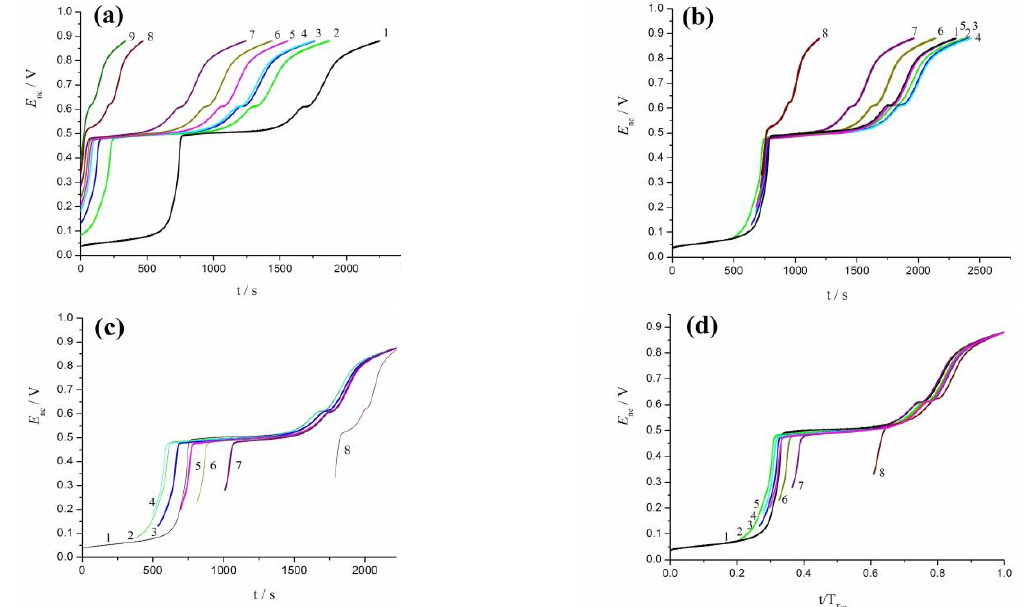
Figure 8. ( a ) Transients of non-current potential in water saturated with CO 2 after the delay of potentials E in Volts (the number of curve): black line: 0. 03 (1); green line: 0.08 (2); blue line: 0.130 (3); cyan line: 0.180 (4); magenta line: 0.200 (5); dark yellow line: 0.230 (6); purple line: 0.280 (7); wine line: 0.330 (8); and, olive line: 0.380 (9). ( b ) Corrected transients of non-current potential by the shift each of the curves (Figure 8a) on the t -axis at the corresponding times of achievement of their initial individual values of the starting potentials on the curve registered from 0.03 V. ( c ) Corrected transients of non-current potential by the shift each of the curves (Figure 8A) on the t -axis by the value Δ t to reach the complete oxidation potential of rCO 2 . ( d ) Normalized corrected curve (Figure 8c) for the individual total T tot time to reach the E nc potential of complete oxidation of rCO 2 .